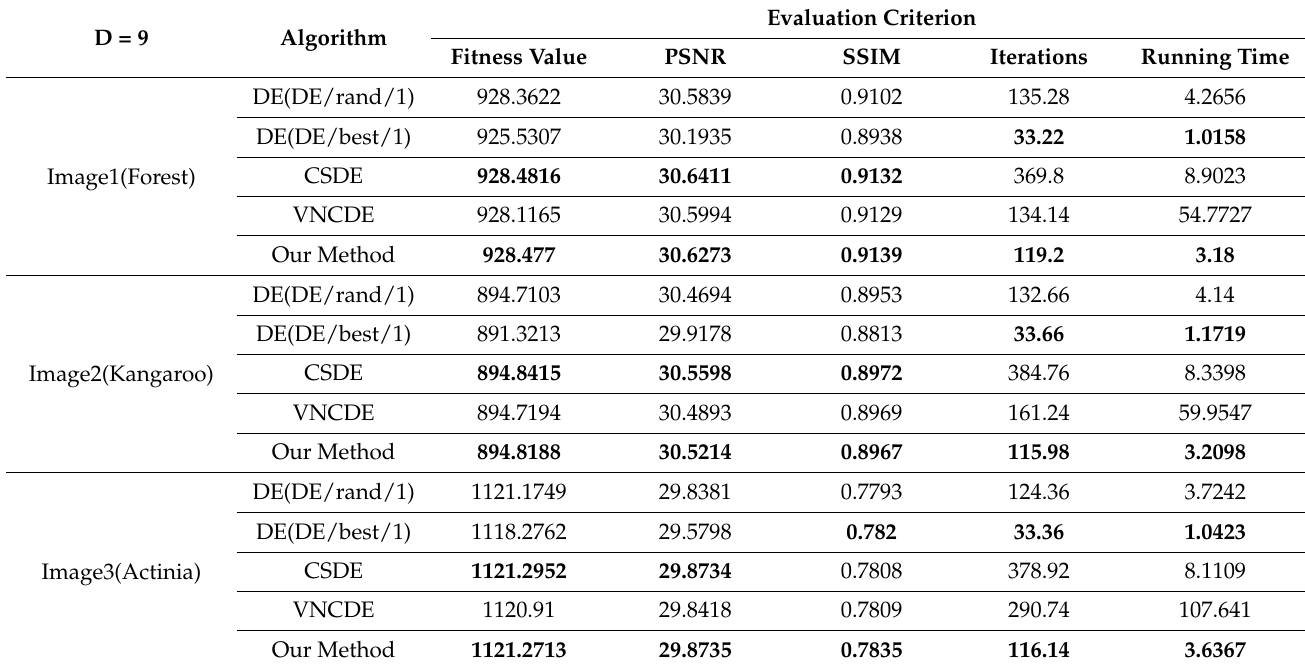
Table 2. Results comparison of five algorithms for segmentation of images 1–3 on different criteria when D = 9.